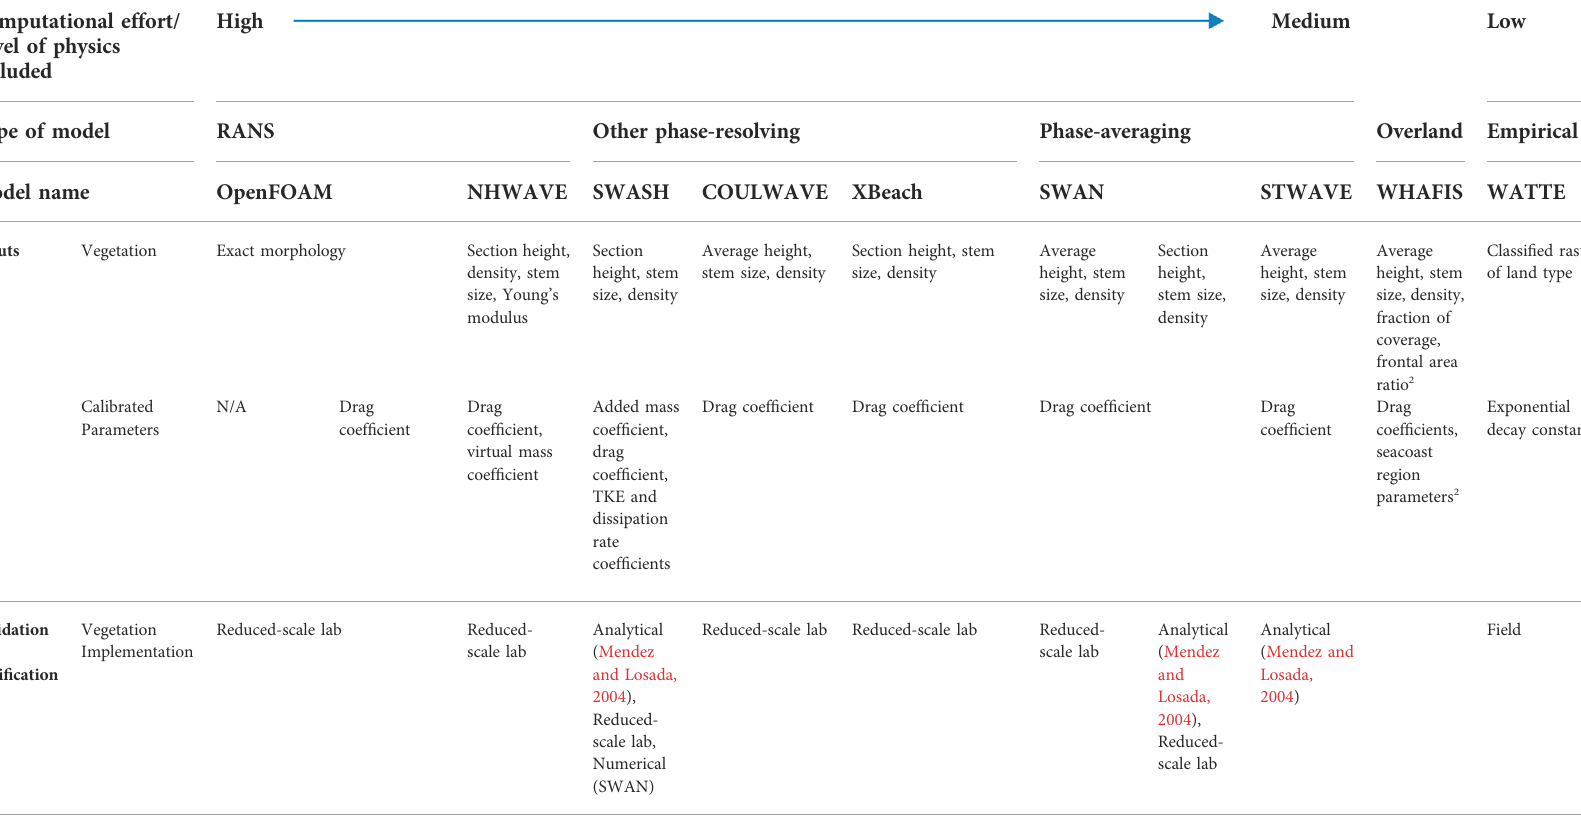
TABLE 2 ( Continued ) Commonly used computational and analytical models for determining wave height attenuation through emergent